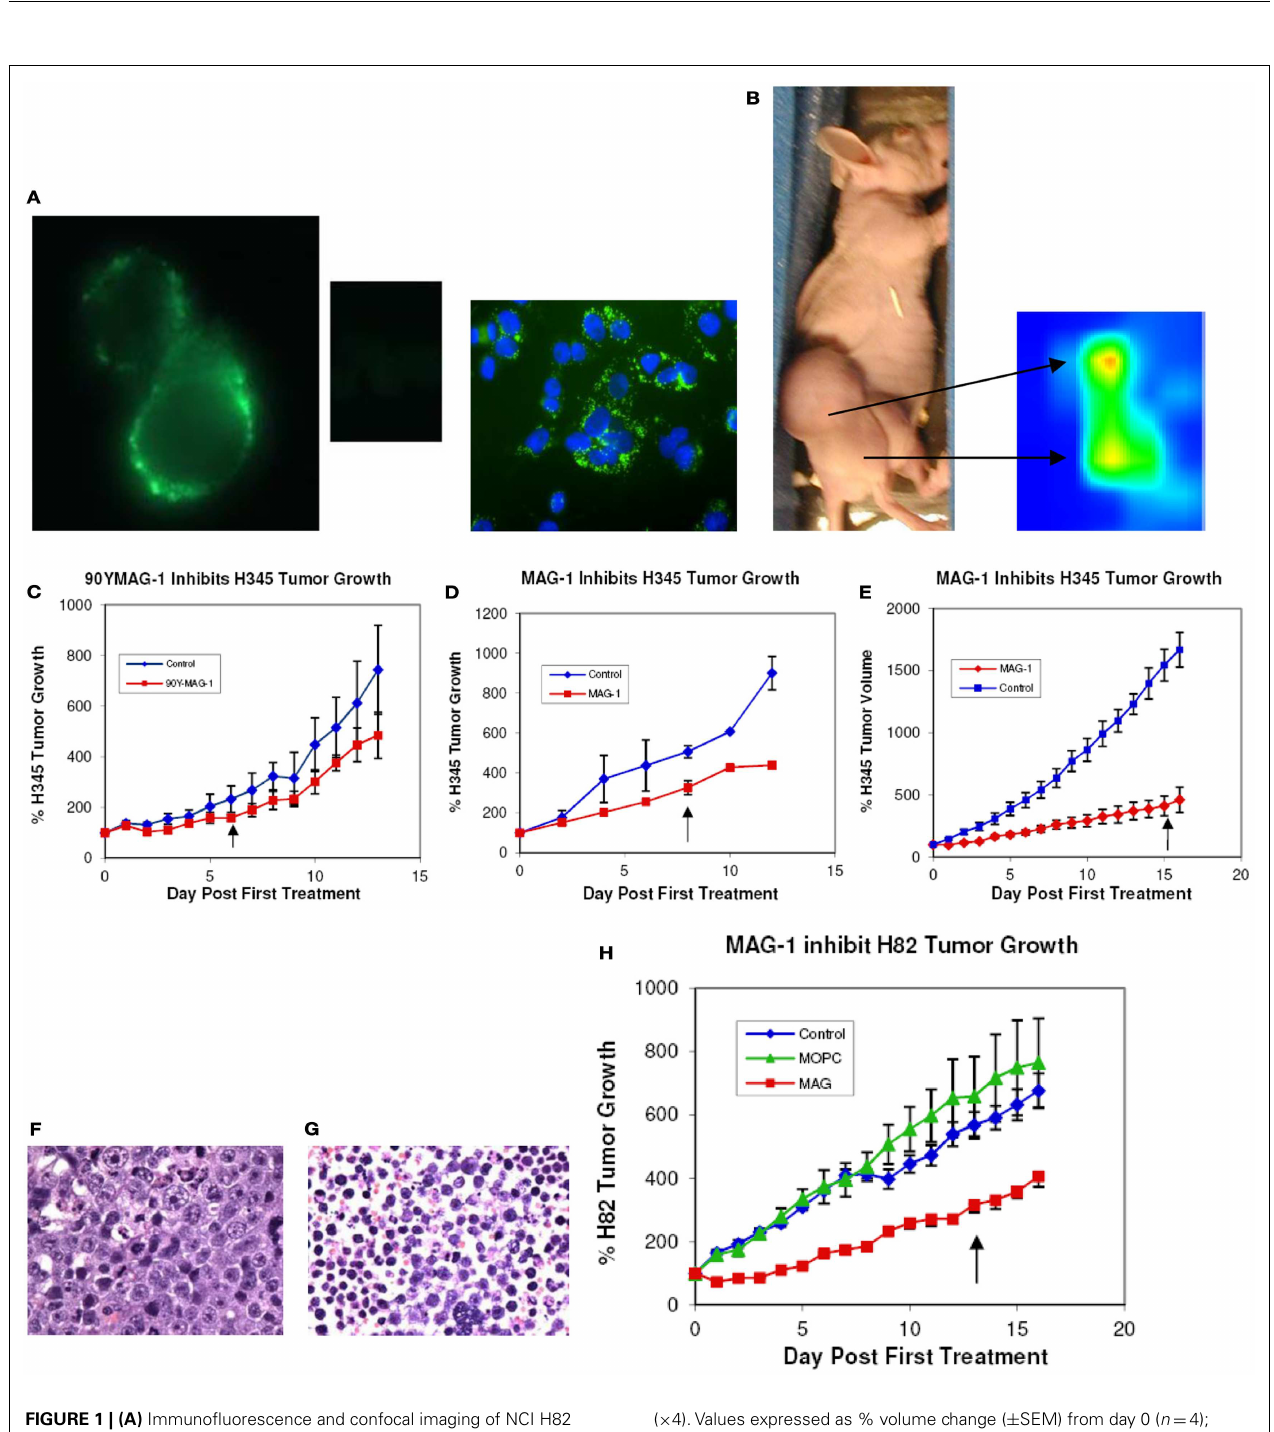
FIGURE 1 | (A) Immunofluorescence and confocal imaging of NCI H82 cells with MAG-1 and MOPC21 (center insert); the blue staining of the confocal image is DAPI; (B) in vivo imaging of NCI H345 tumor in nu/nu mouse with 99 Tc-DTPA-CHX-A (cid:48)(cid:48) -Fab MAG-1 at 20h after administration of label; (C) treatment of NCI H345 tumor in nu/nu mice with 50 µ Ci 90 Y-DPTA-CHX-A (cid:48)(cid:48) -MAG-1 (50 µ g/30g body weight total antibody) given alternate days ( × 4).Values expressed as % change in mean tumor size ( ± SEM) from day 0 ( n = 4); (D) treatment of NCI H345 cells tumors in nu/nu mice with native MAG-1 (50 µ g/g body weight) given alternate days